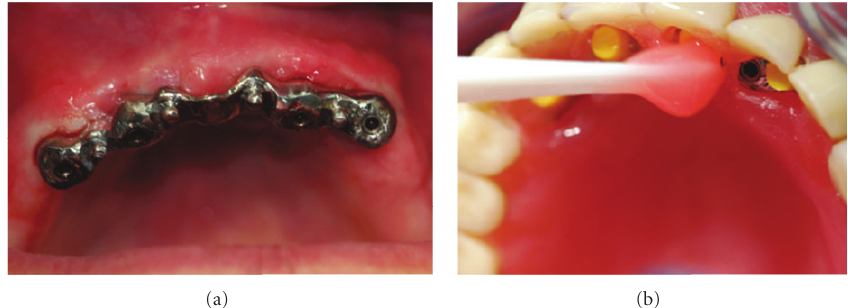
Figure 5: (a) The bar reapplied into the mouth. (b) The OT Caps fixed with acrylic to the